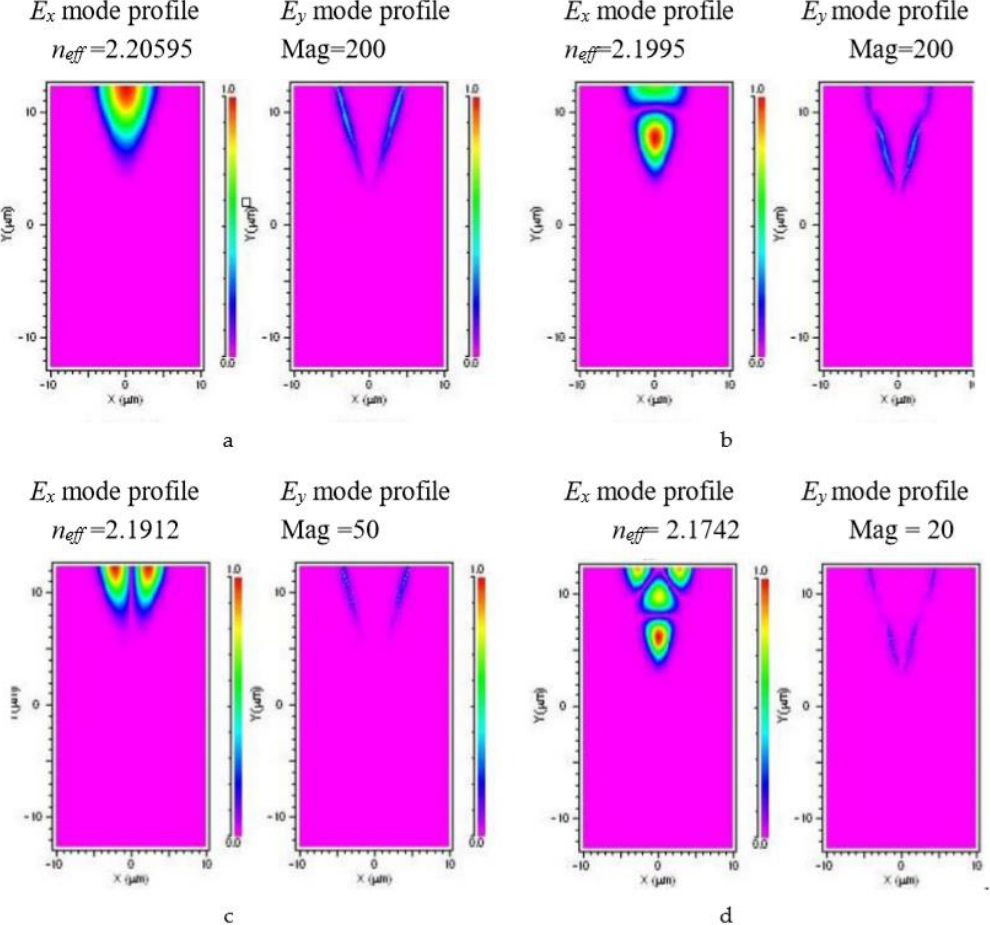
Figure 12. ( a – d ). Calculated E x and E y mode profiles for lithium niobate channel waveguides